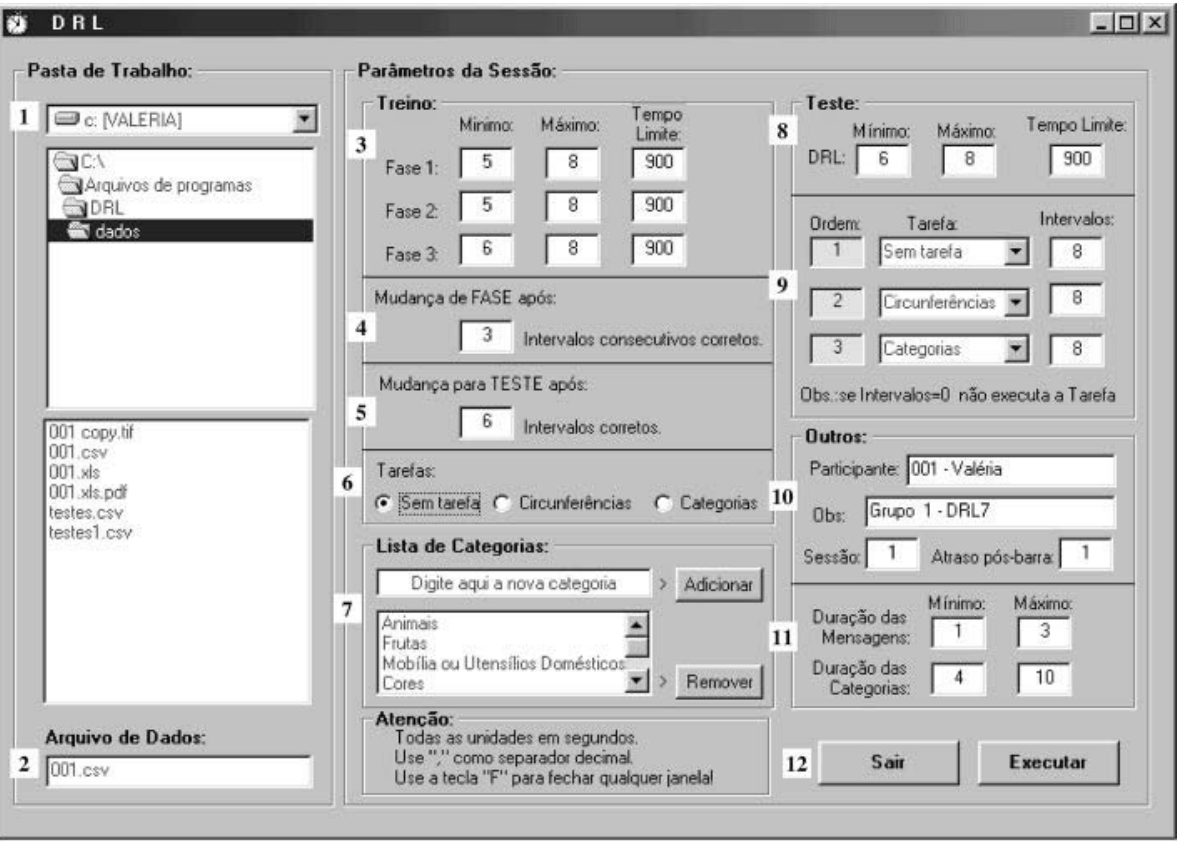
Figura 1 . Menu inicial de configurações do programa “DRL”. Os números indicam itens cuja função é detalhada no corpo do texto. Na Figura1 é apresentado o menu inicial de configura- ções do programa “DRL”; a função de cada campo do menu é detalhada a